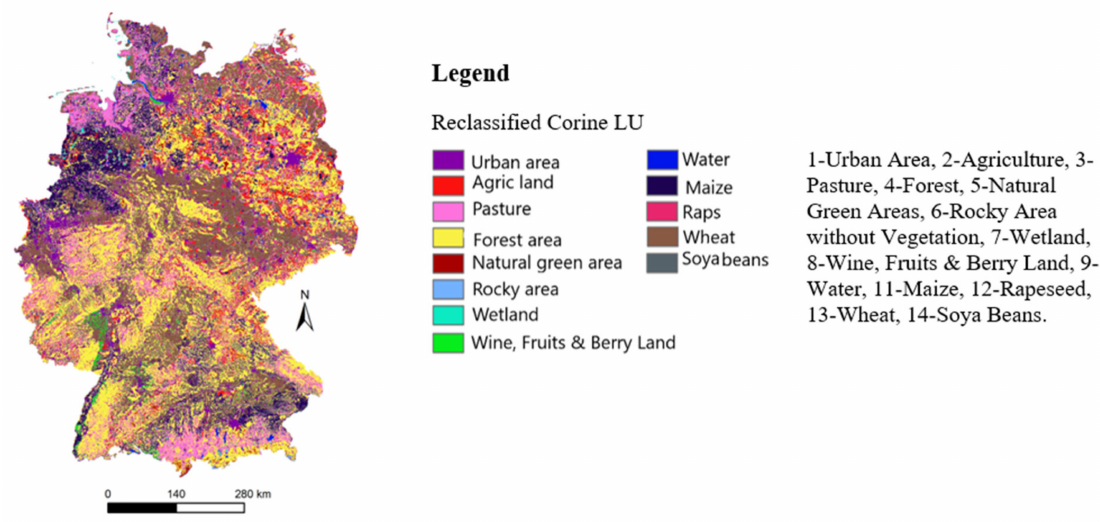
Figure 5. Reclassified land use map to include the agricultural land use vital for energy feedstock’s needed in our RGPs. Our reclassified map shows more maize in the west where our new maize RGPs can be suitably